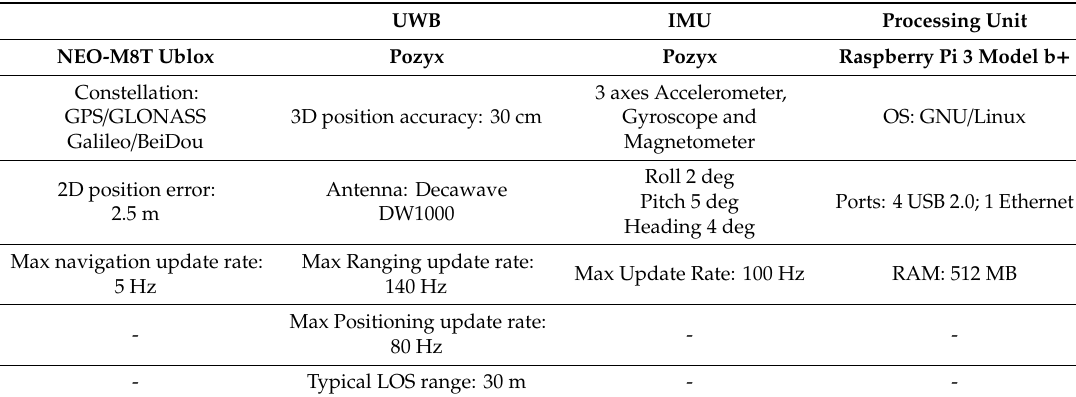
Table 1. Performance specification of multisensor